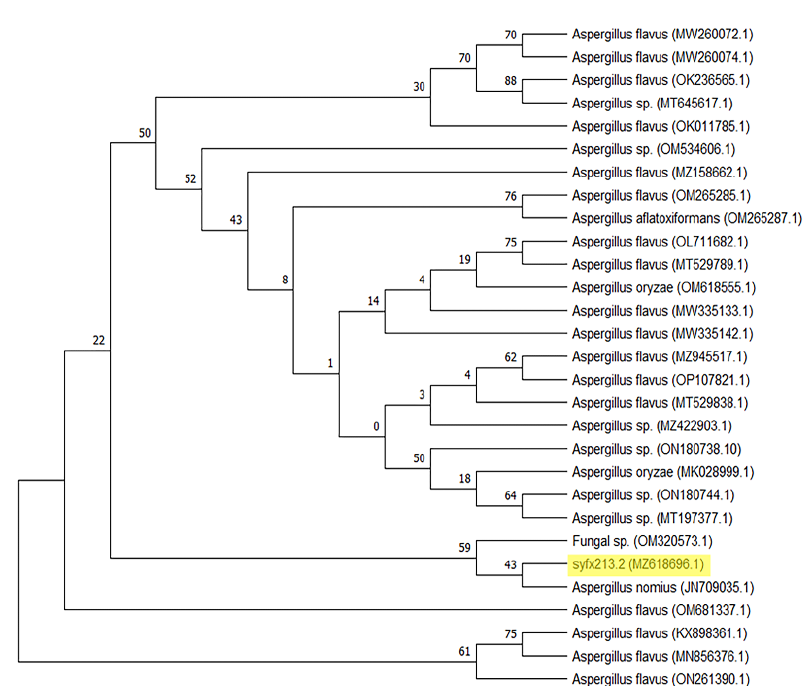
Figure 2. Fungal strain SY fx2 13.2 and its internal transcribed spacer ITS DNA phylogenetic tree. Numbers in brackets indicate GenBank accession number.